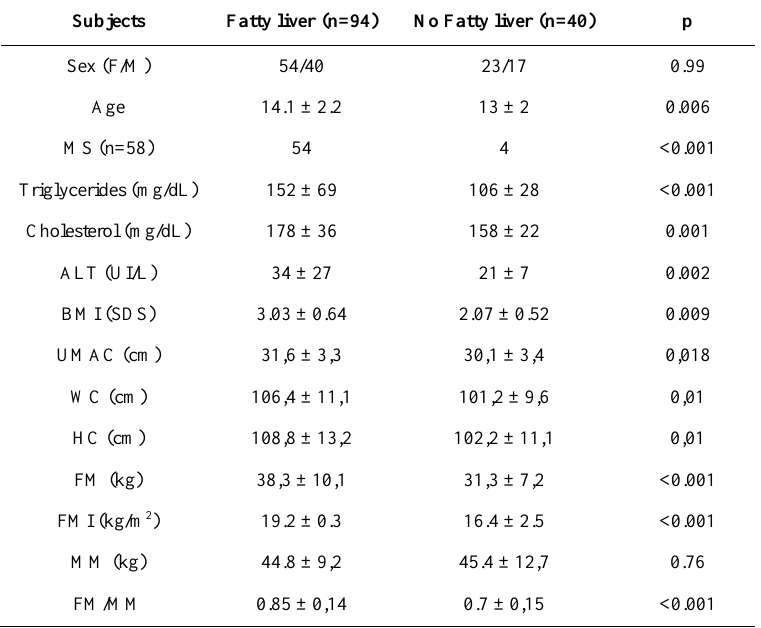
Table 1. Demographic, indirect measurement methods and BIA findings in cases according to fatty